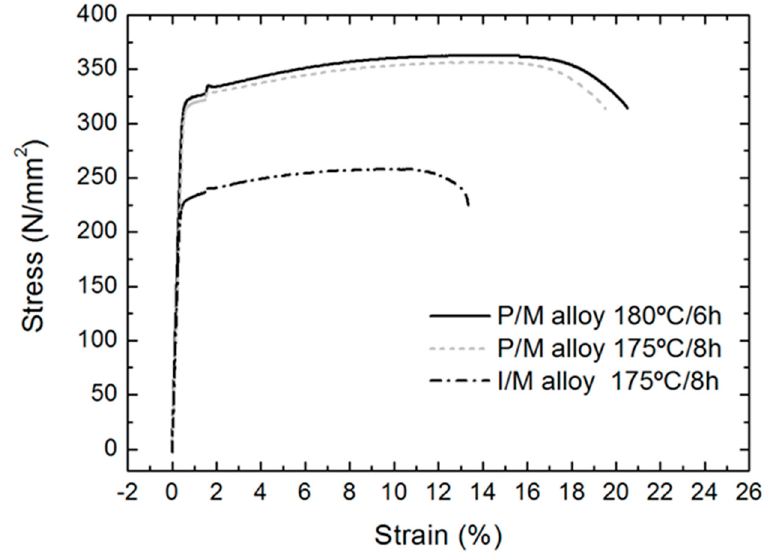
Figure 8. Tensile engineering stress–strain curves of aged extruded profiles at 500 ° C from AA 6005A compacted powders (AA 6005A powder metallurgy (P/M) alloy) and from the ingot metallurgy (I/M) route (AA 6005A I/M alloy). Table 3. Mechanical properties of age hardening extruded profiles at 500 ° C from AA 6005A